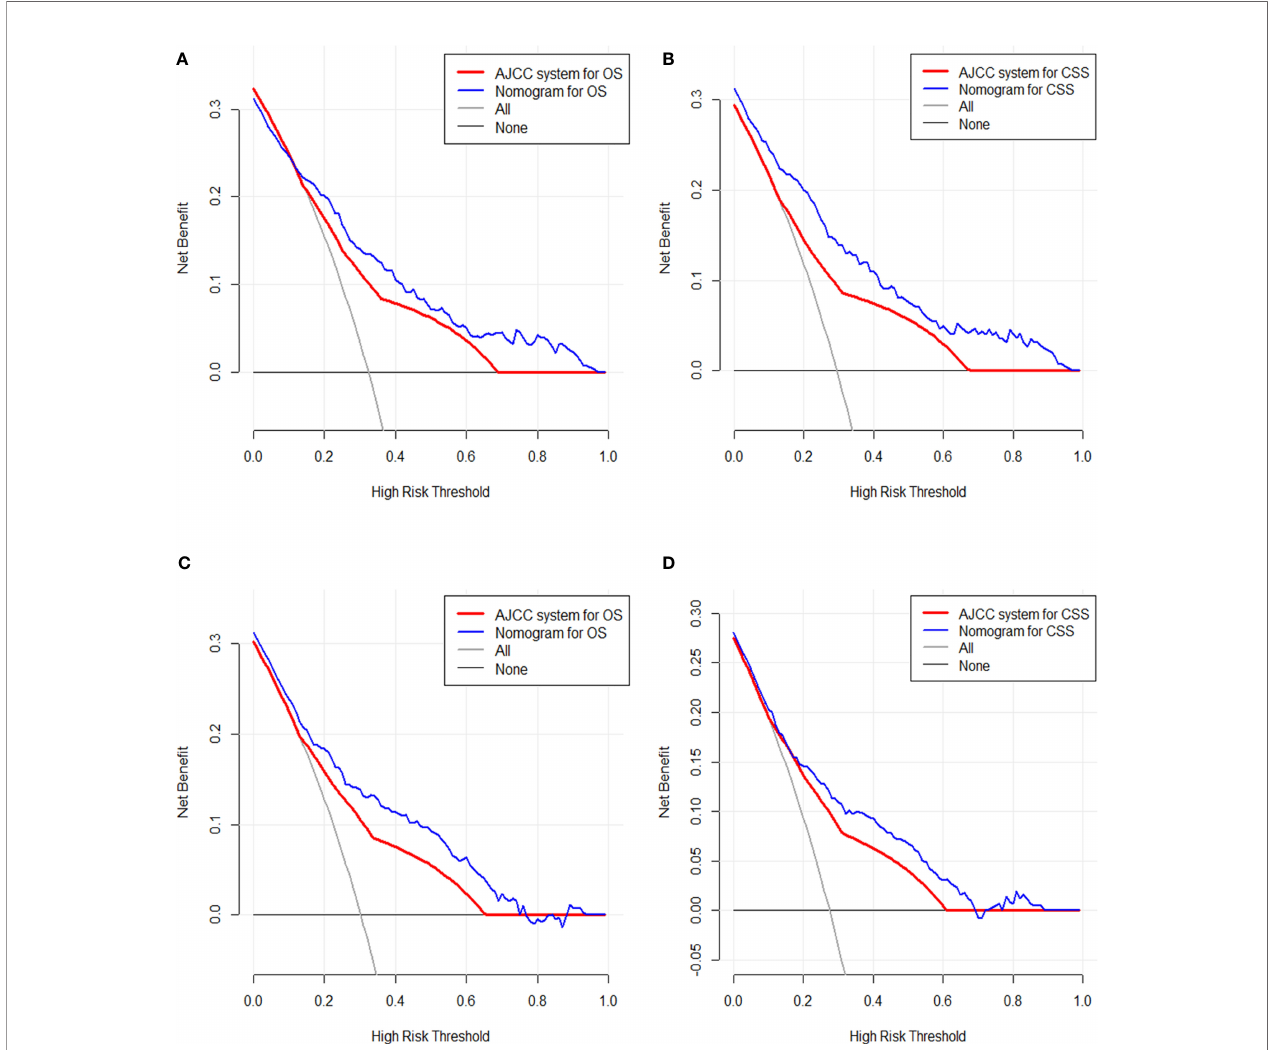
FIGURE 5 | Decision curve analysis of the clinical utility between the nomograms and American Joint Commission on Cancer (AJCC) staging system regarding the overall survival (OS) (A) and cancer-speci fi c survival (CSS) (B) in the training cohort and OS (C) and CSS (D) in the validation